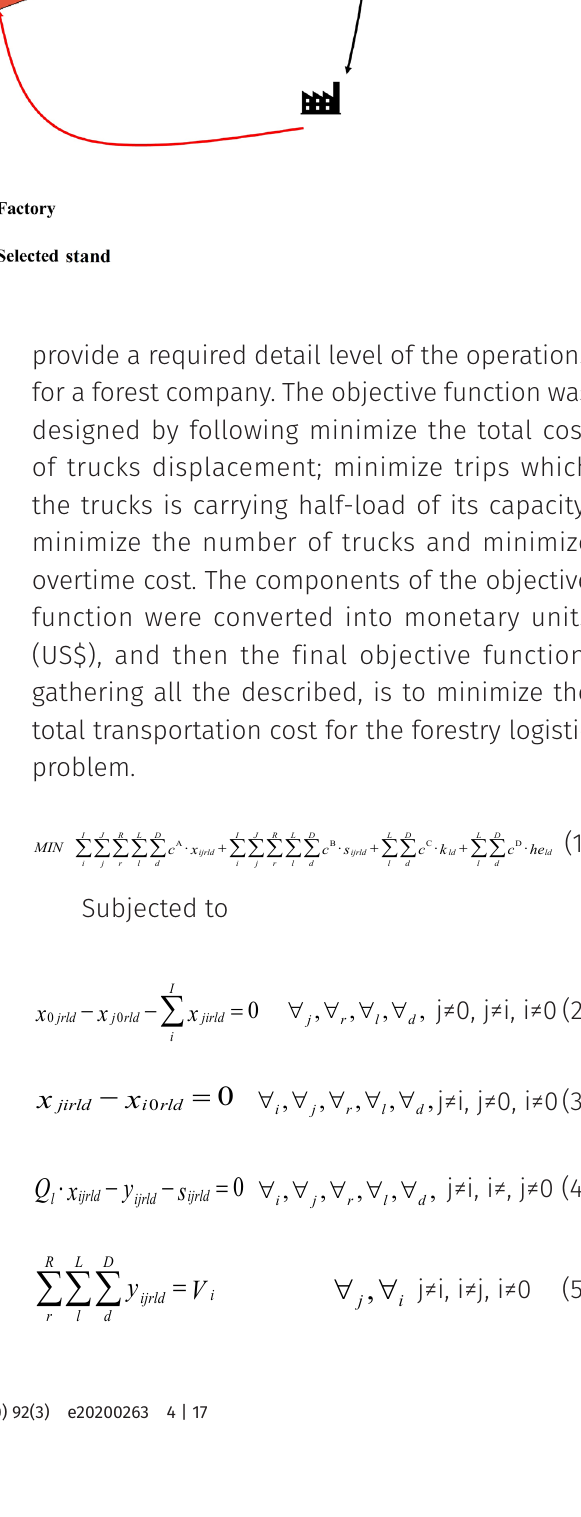
Figure 1. Scheme of simple (a) and multiple (b) displacement of trucks during the